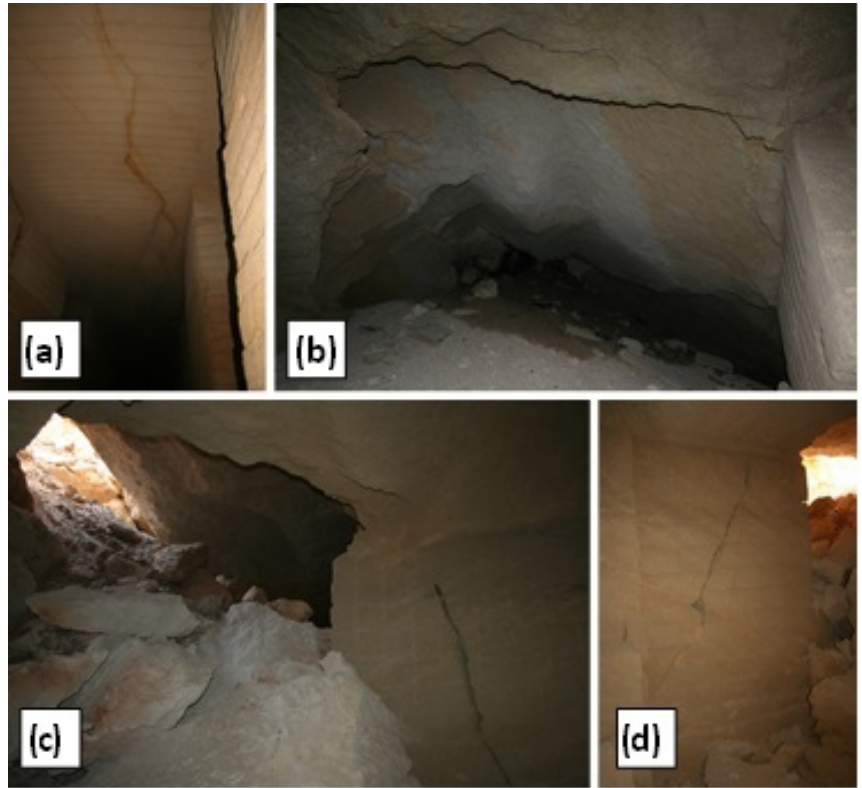
Figure 7. Instability evidence at the Barletta underground quarry: (a) tensile fracturing of the vault; (b) block detachment from the vault; (c) open fractures on pillars, and vault collapses in the area closest to the sinkhole; (d) crushing of pillar with joints (adapted from De Giovanni et al.,